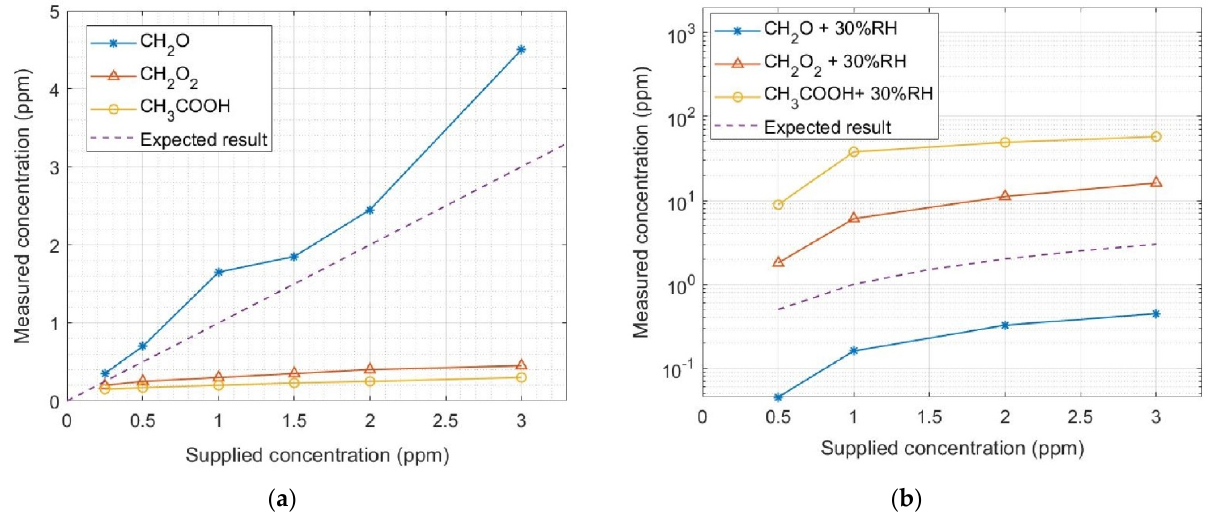
Figure 9. Calibration profile of a commercial TVOC sensor when exposed to different concentrations of formaldehyde (CH 2 O), formic acid (CH 2 O 2 ), and acetic acid (CH 3 COOH), diluted in ( a ) dry synthetic air and ( b ) 30% relative humidity (RH). Note: the results in ( b ) are presented in log scale for a better visualization of the considerable mismatch between the supplied and measured concentrations.